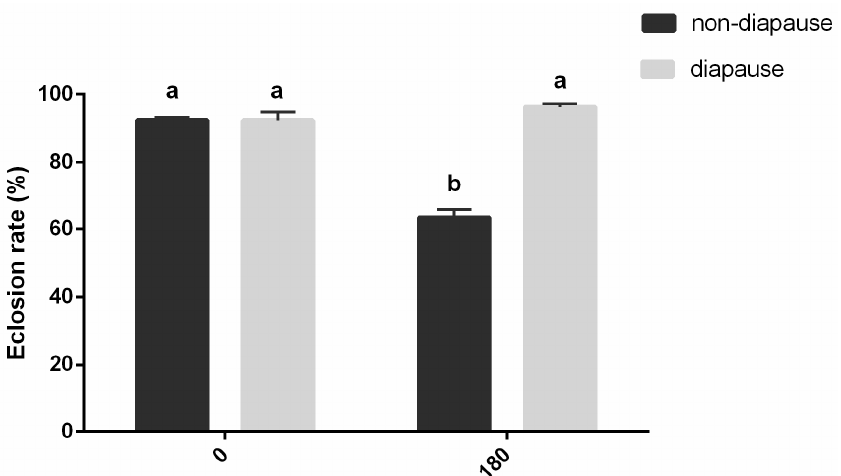
Figure 4. Effect of chilling period on survival of diapausing and nondiapausing mature larvae of A. japonicus (mean ± SE%). Different letters indicate significant difference (two-way ANOVA followed by Bonferroni’s multiple comparison tests, p < 0.05) between different chilling periods and